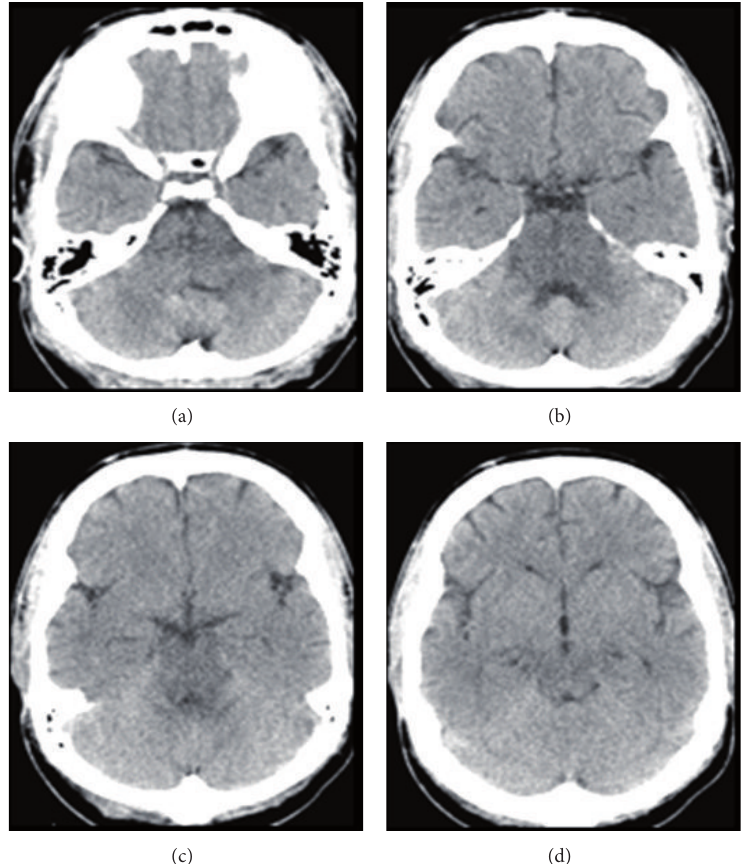
Figure 1: Noncontrast brain CT scan showing isolated hypodensity of the whole Pons ((a) and (b)) and midbrain ((c) and (d)) with narrowed prepontine, cerebellopontine, and ambient